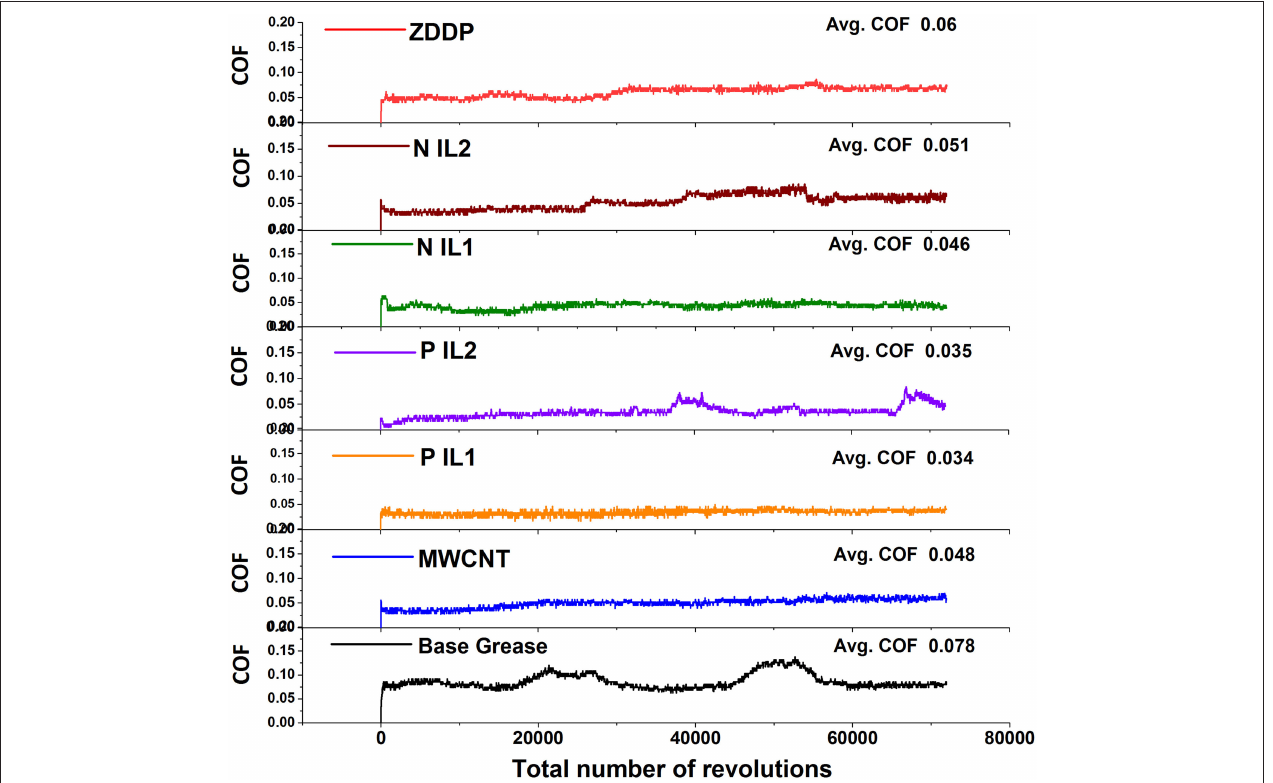
FIGURE 1 | Coefficient of Friction from four ball wear tests for greases containing only MWCNT and only ILs additives compared with base grease and ZDDP grease blend.